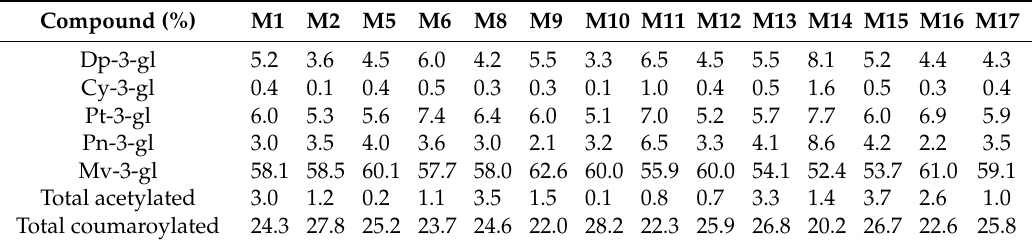
Table 3. The anthocyanins profile of berry